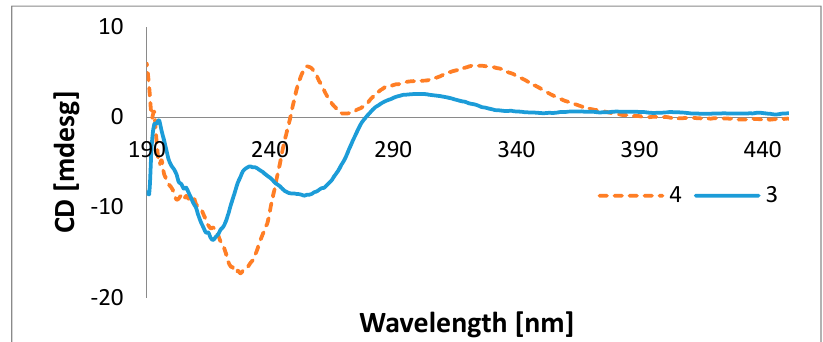
Figure 3. ECD spectra of Compounds 3 and 4 in ethanol.